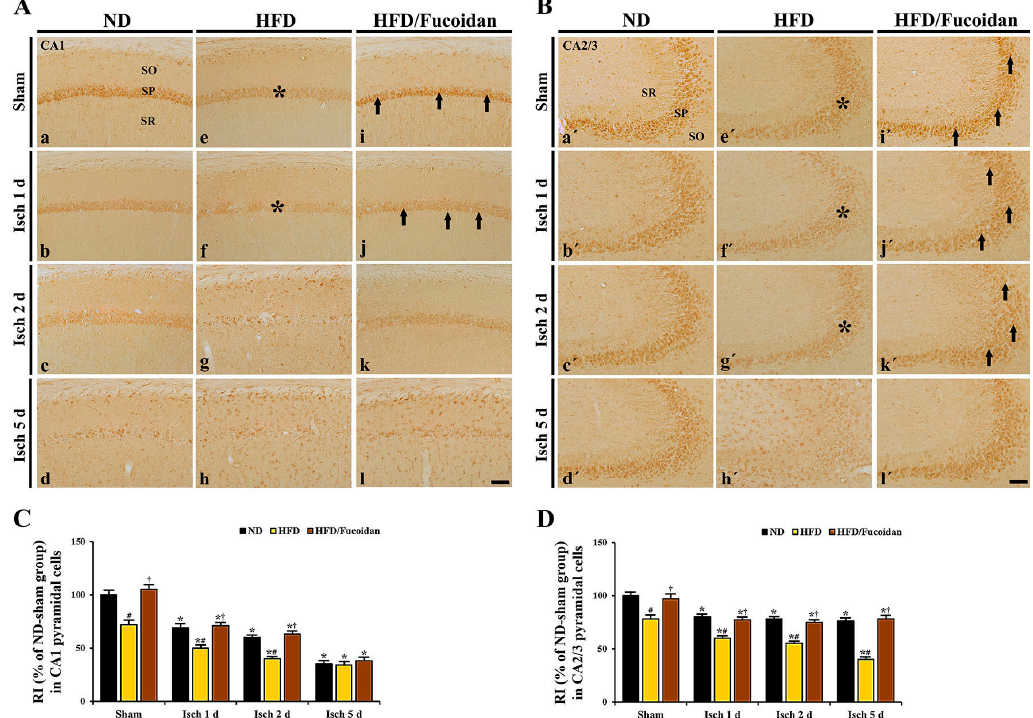
Figure 8. ( A , B ) SOD1 immunohistochemistry in the CA1 ( A ) and CA2/3 ( B ) areas of the ND-fed (left columns), HFD-fed (middle columns) and HFD/Fucoidan-fed (right columns) groups at sham (a, e i, a´, e´, i´), 1 day (b, f, j, b´, f´, j´), 2 days (c, g, k, c´, g´, k´) and 5 days (d, h, l, d´, h´, l´) after tGCI. In the HFD-fed group, SOD1 immunoreactivity in CA1-3 pyramidal cells (asterisks) is significantly lower